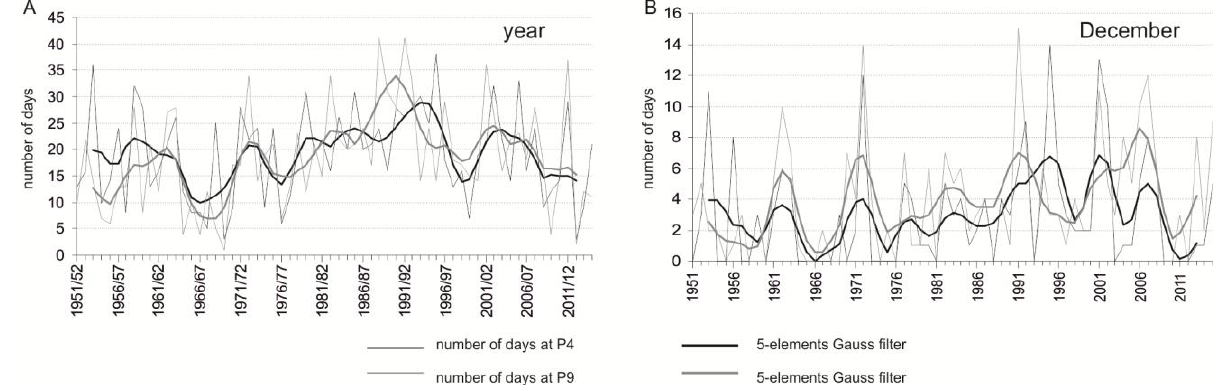
Fig. 5. Long-term variability of annual (A) and December (B) number of days with SHP at selected grid points in the period 1951-2015 Table 5. Tendency of number of days with SHP changes [days/10 years] at selected grid points in the period 1951-2015 Grid